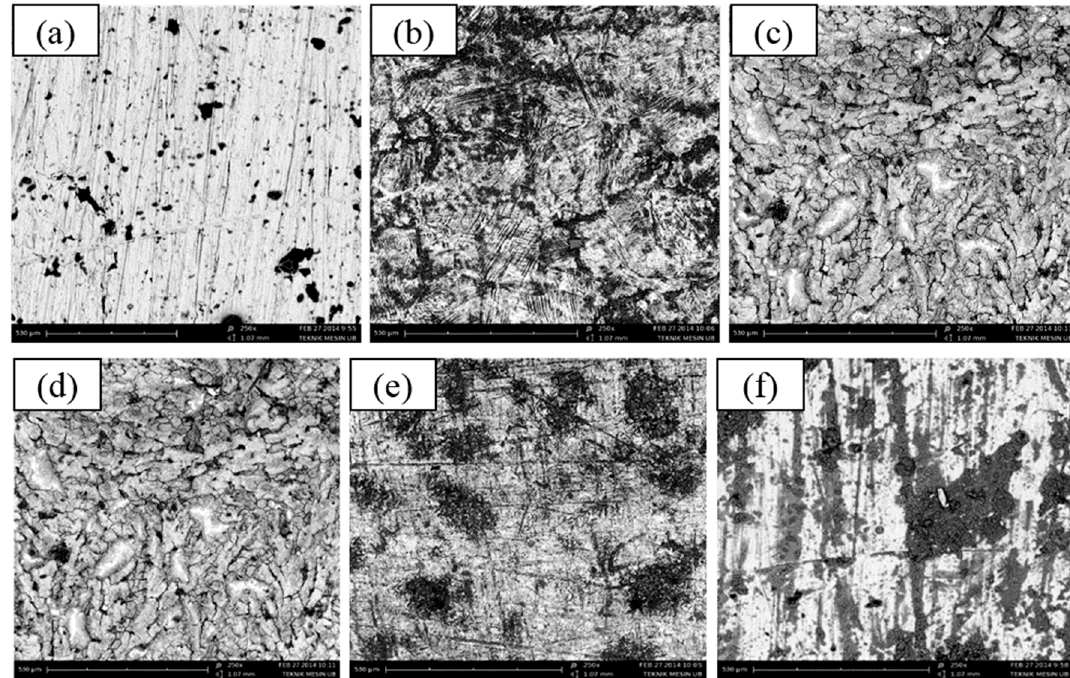
Figure 10. Scanning electron spectroscopy (SEM) images of the 304 SS surface in 250× before corrosion ( a ), after corrosion in 1.0 M H 2 SO 4 without inhibitor ( b ) after corrosion in 1.0 M H 2 SO 4 with inhibitor 1000 mg/L ( c ), after corrosion in 1.0 M H 2 SO 4 with inhibitor 2000 mg/L ( d ), after corrosion in 1.0 M H 2 SO 4 with inhibitor 3000 mg/L ( e ), after corrosion in 1.0 M H 2 SO 4 with inhibitor 4000 mg/L ( f ).